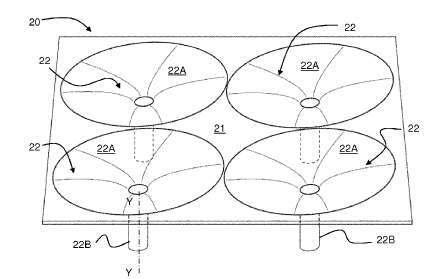
Figure 20. Landing platform for unmanned aerial vehicles with funnels for each leg [61] by Telecom Italia SpA. 20, landing platform; 21, flat surface; 22, centering funnels; 22A, truncated cone part of funnel; 22B, cylindrical part of funnel.